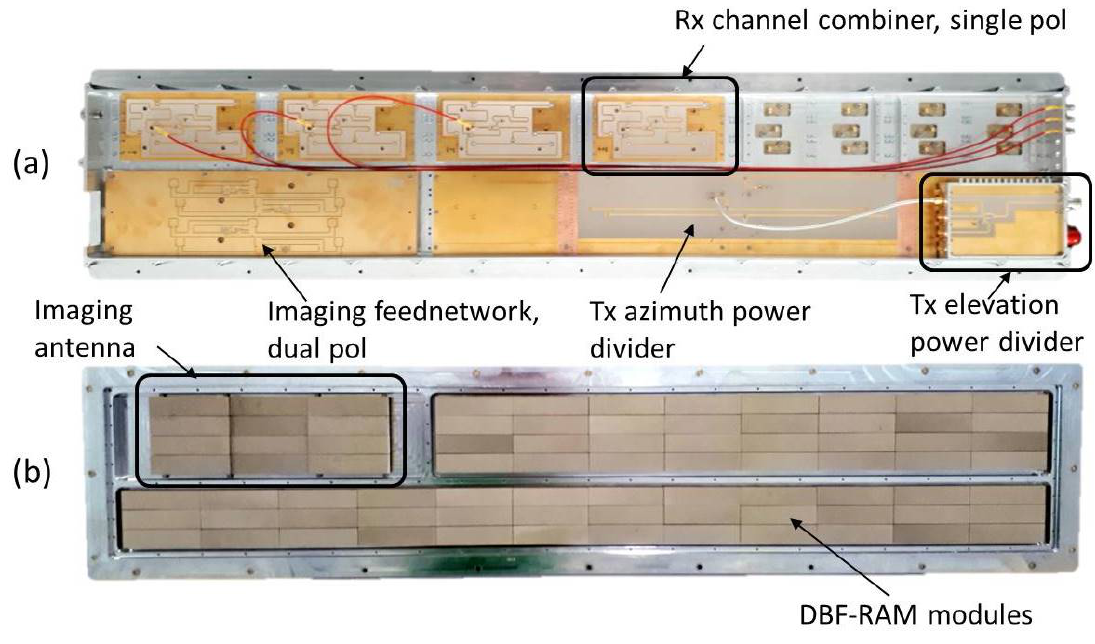
Figure 4. ( a ) Partially assembled V-SAR antenna with multiple RX channels and two individual transmit antenna configurations. View into the feeding network structures; and ( b ) view to the front part of the V-SAR multi-channel antenna without radome, consisting of 80 DBFRAM